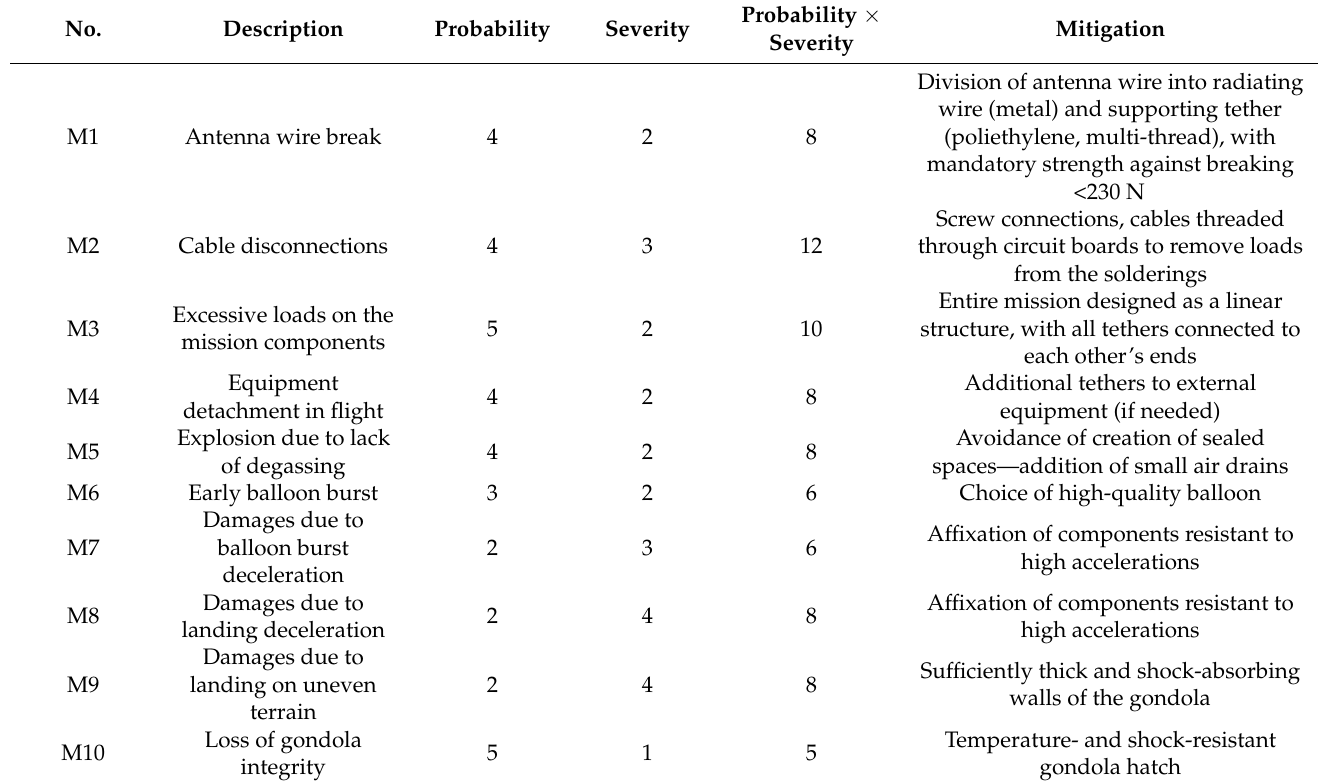
Table 2. Mechanical risks for a stratospheric fully airborne VLF light balloon